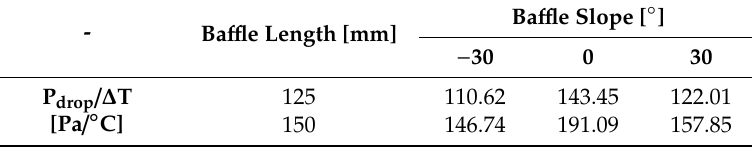
Table 8. Pressure drop and temperature di ff erence ratio depending on